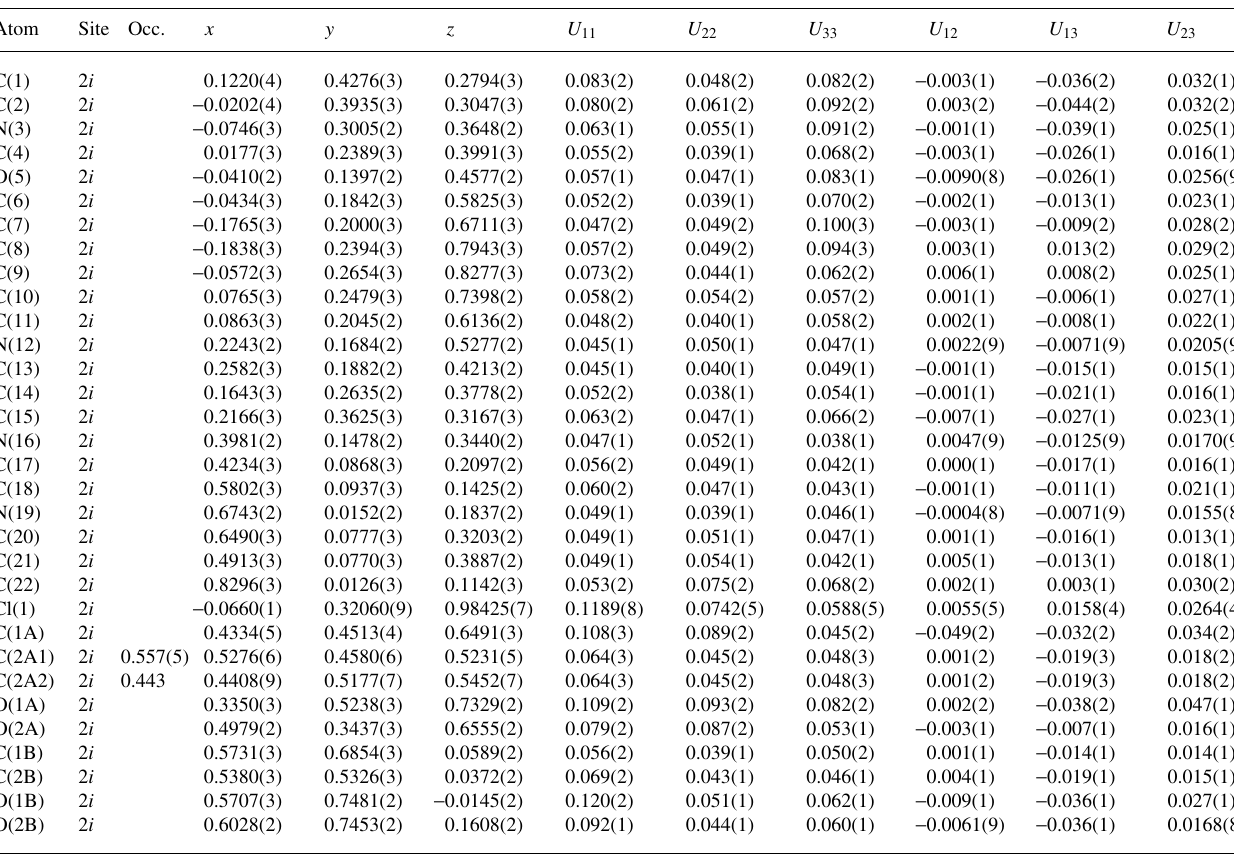
Table 3. Atomic coordinates and displacement parameters (in Å 2 ) .